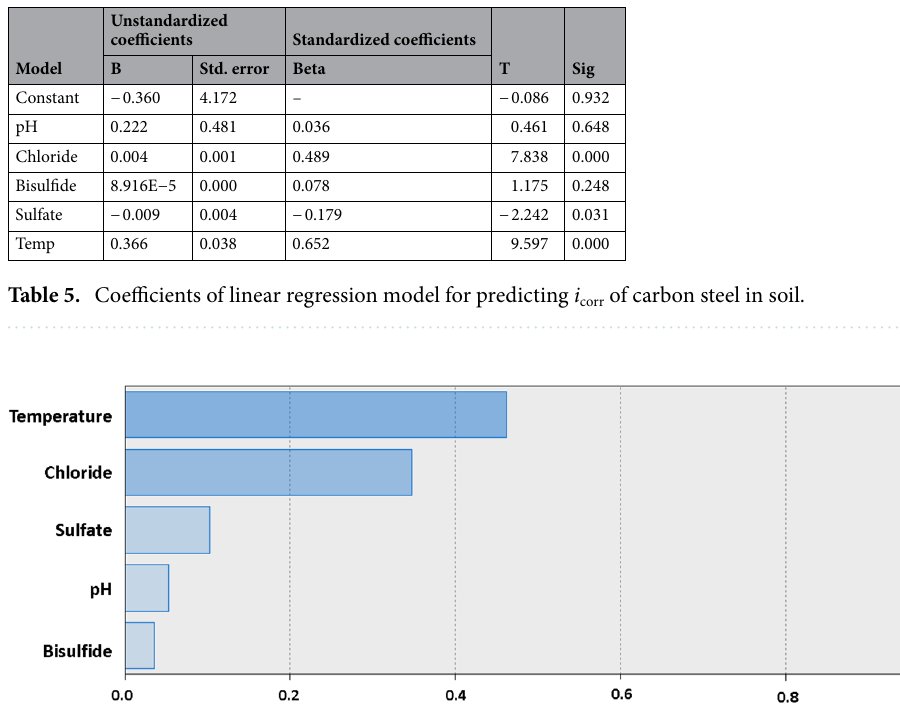
Figure 13. Chart for the standardized effects of temperature, chloride, sulfate, bisulfide, and pH, as predicted by LR on the corrosion current density of carbon steel in